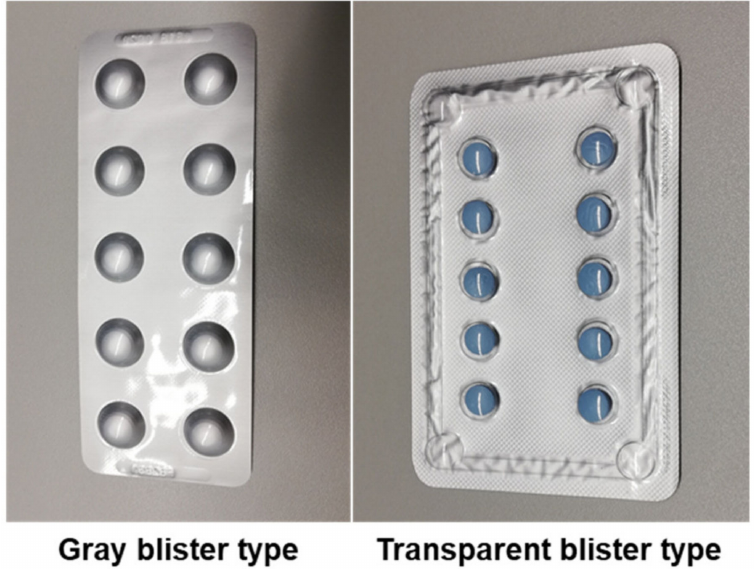
Figure 5. Examples of different blister types used in the